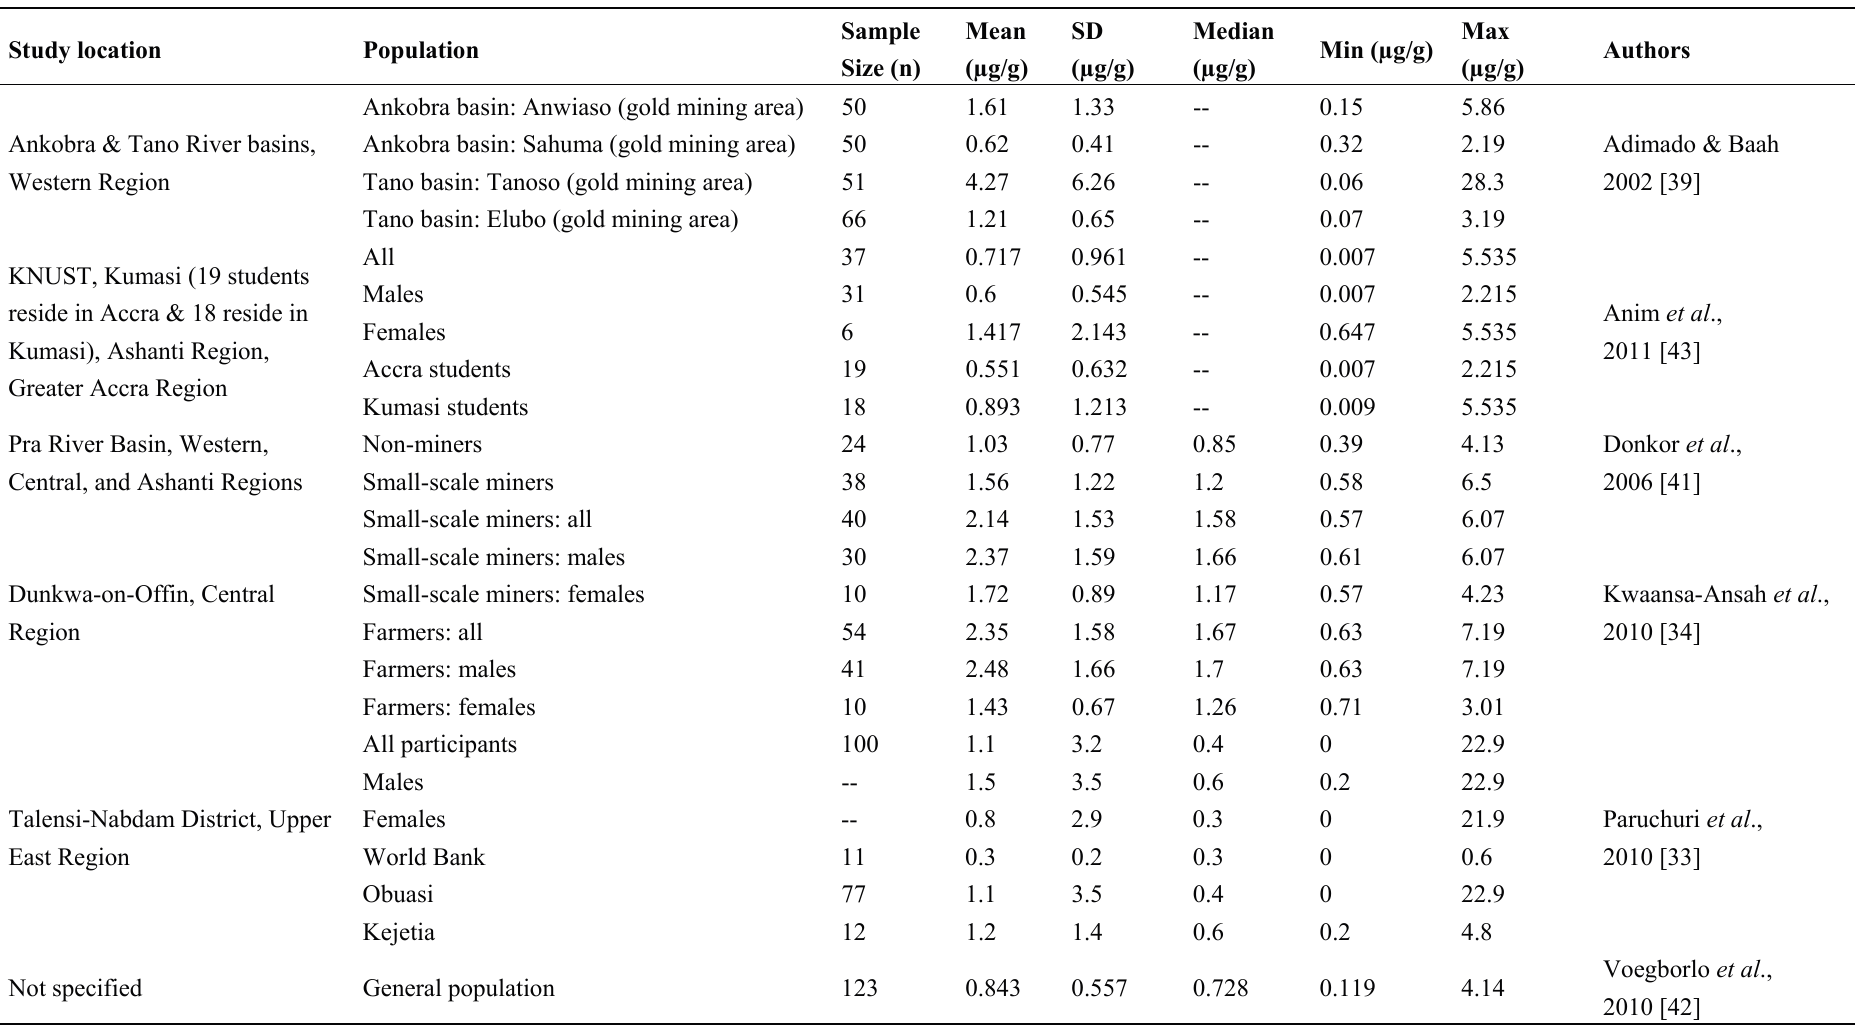
Table A2. A summary of mercury concentrations in human hair samples from ASGM miners and non-miners from across Ghana. Study